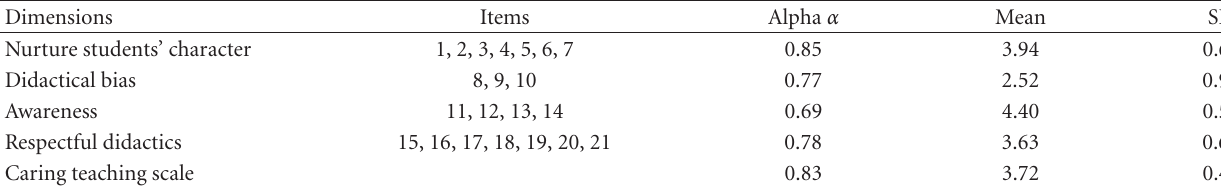
Table 4: Four dimensions of caring